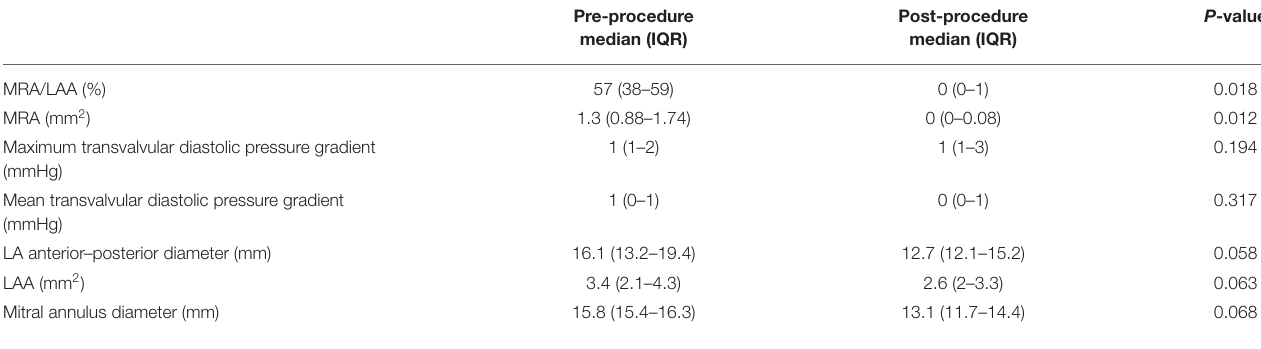
TABLE 1 | Hemodynamic, cardiac-size and mitral valve functional changes after the ValveClamp procedure.